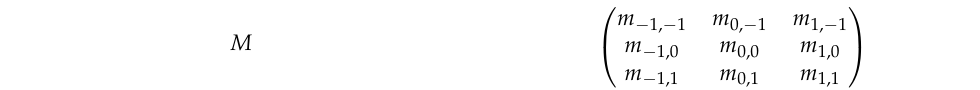
Table 2. Coefficient notation for M = A , B ( m = a , b ) . Notice that the coefficient for the current node is ( 0,0 ) .